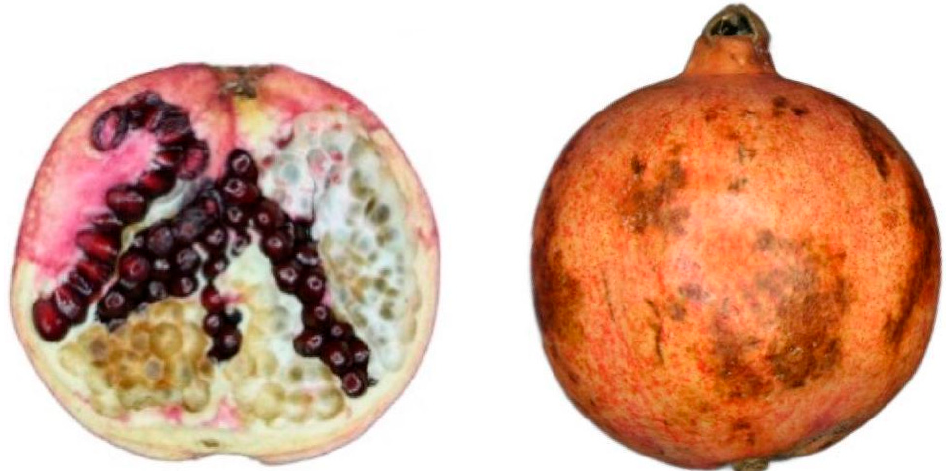
Figure 2. Chilling injury symptoms in pomegranate ‘Wonderful’ fruit including external skin discoloration, and internal albedo browning and aril color changes from red to brown after 120 days of storage at 3.5 °C and ≥ 95% RH.